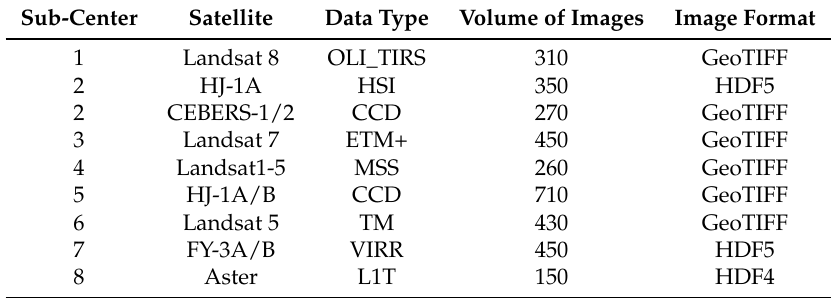
Table 3. A Summary of the Experimental Images.